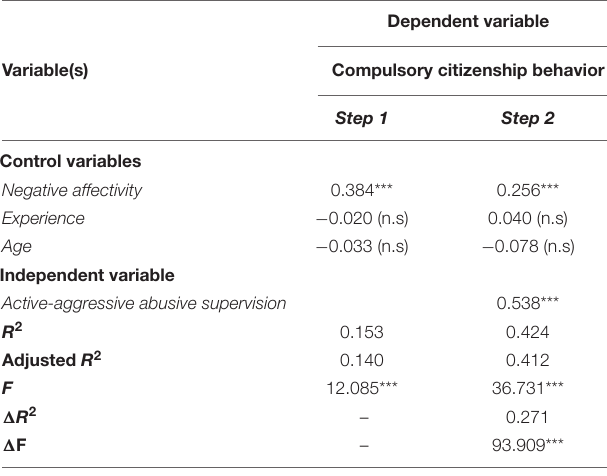
TABLE 2 | Regression analysis with active-aggressive abusive